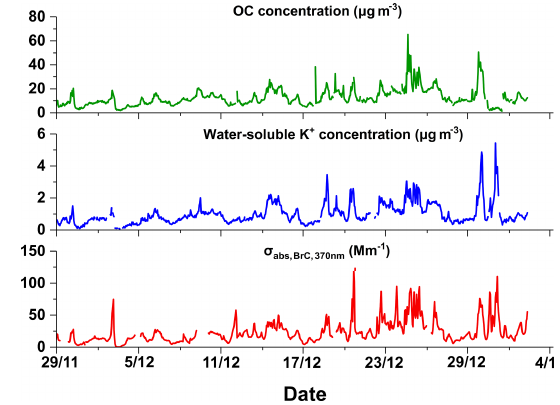
Figure 5. Time series of the OC aerosol mass concentration (green line), water-soluble K + mass concentration (blue line), and BrC light absorption (red